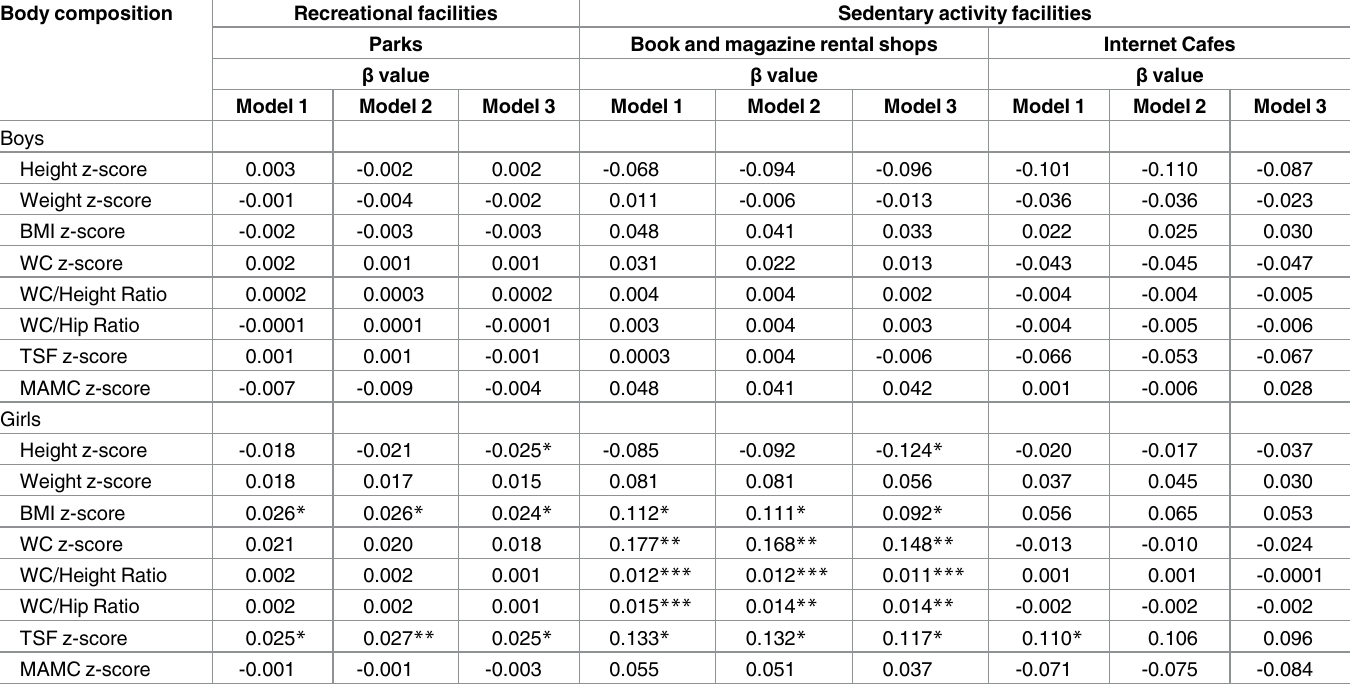
Table 5. Multiple linear regressions for body composition in relation to the recreationalor sedentary activity facilities within 1000m a around junior high school by gender.